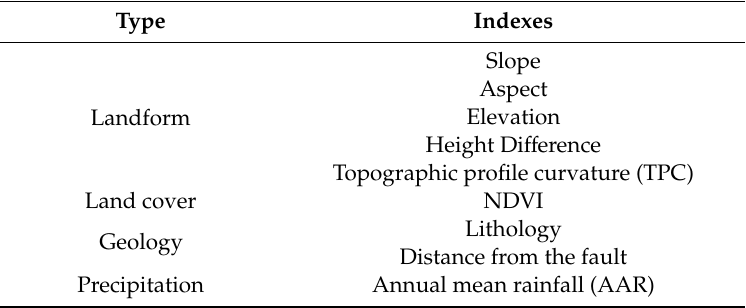
Figure 5. Correlation coefficient between evaluation indexes for hazard assessment. Table 2. Factors selected for landslide hazard